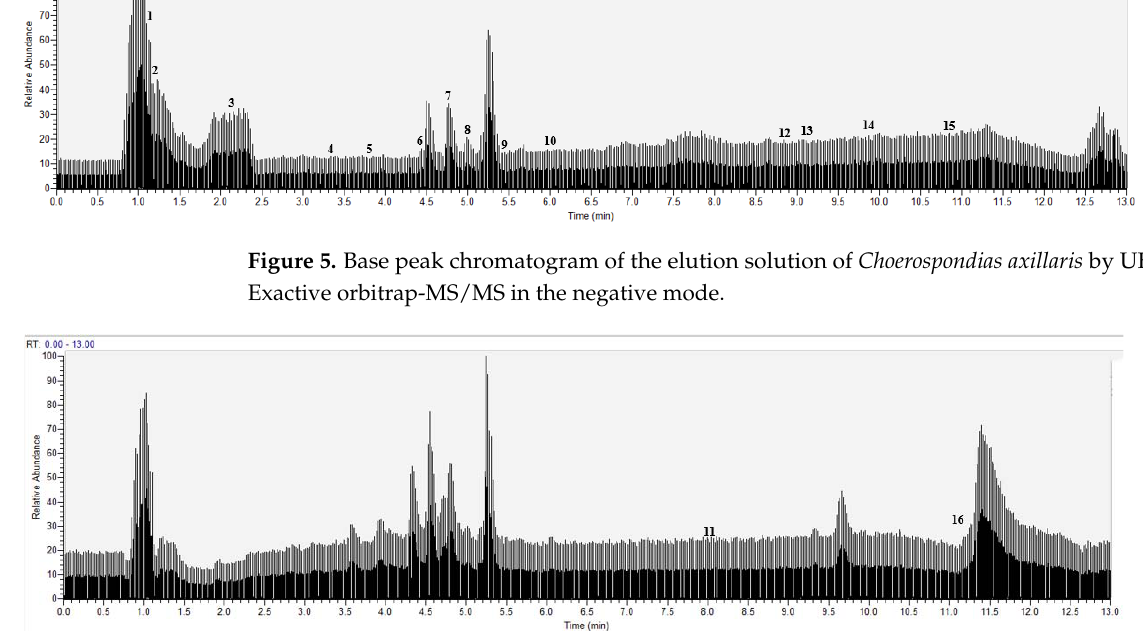
Figure 6. Base peak chromatogram of the elution solution of Choerospondias axillaris by UHPLC-Q- Exactive orbitrap-MS/MS in the positive mode. Table 2. Identification of elution solution by UHPLC-Q-Exactive Orbitrap-MS/MS.